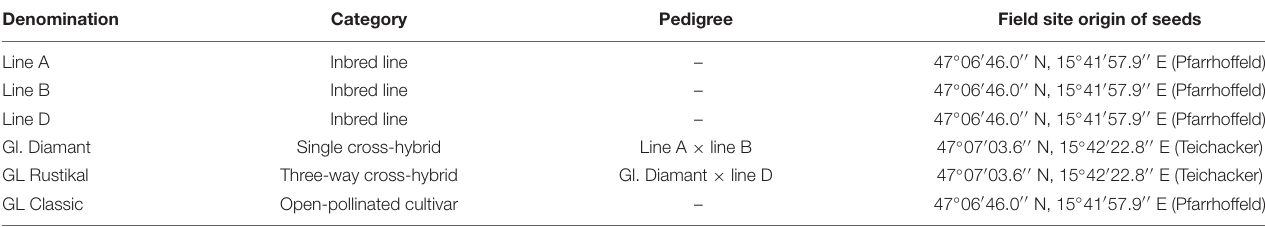
TABLE 1 | Characteristics of Cucurbita pepo genotypes selected for the microbiome